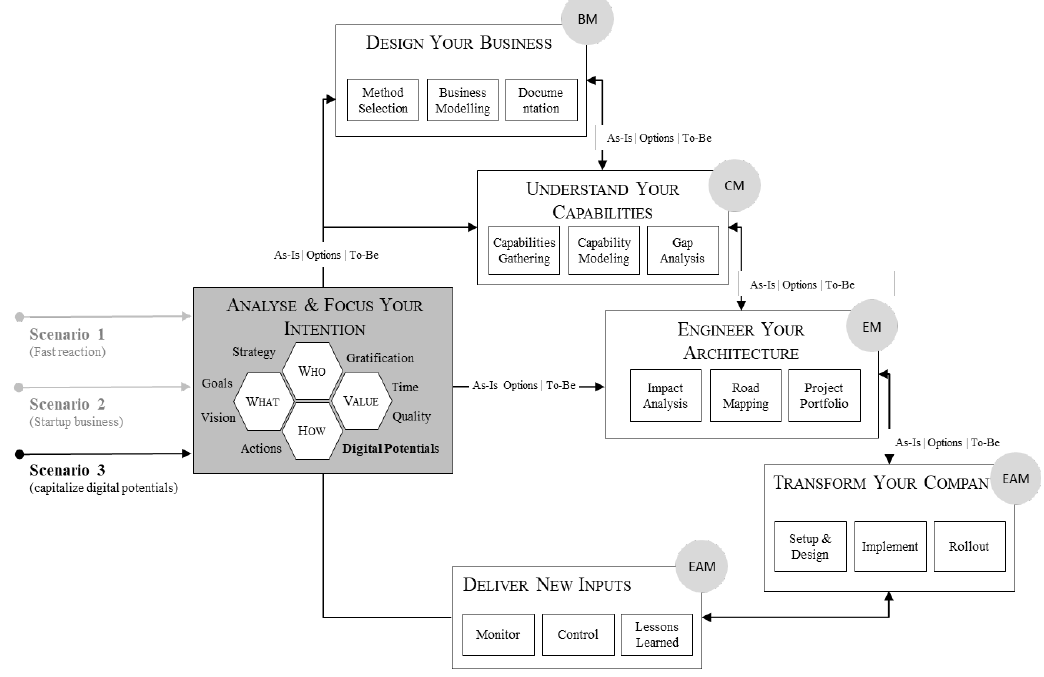
Figure 1. Digital Innovation and Transformation Process Approach, based on